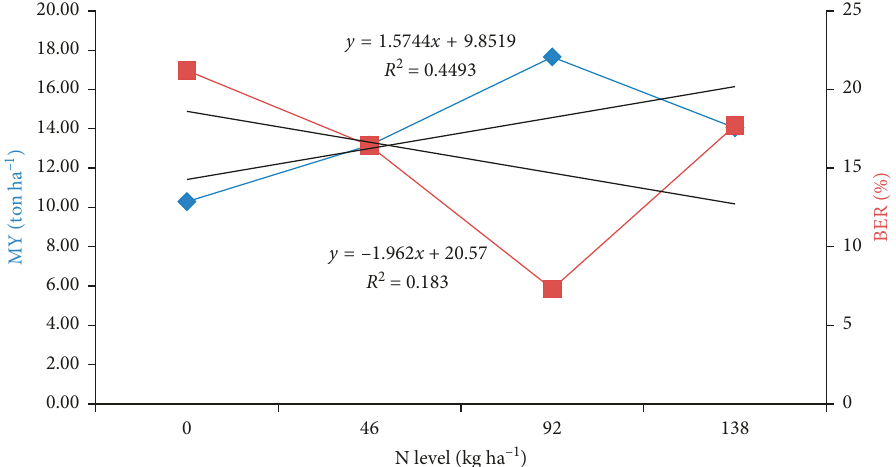
Figure 2: Relationship of nitrogen (N) levels with marketable yield (MY) and BER incidence. Table 3: Marginal rate of return (MRR) and dominance